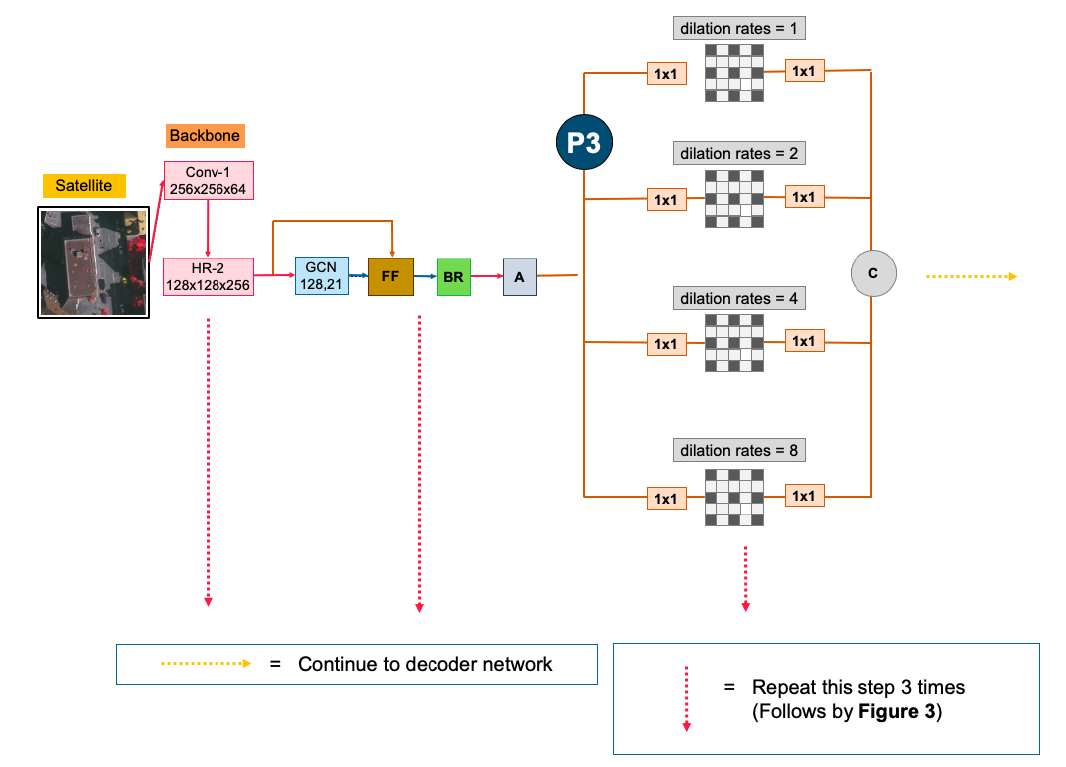
Figure 5. The Depthwise Atrous Convolution (DA) module in the proposed parallel pyramid method for improving feature fusion.